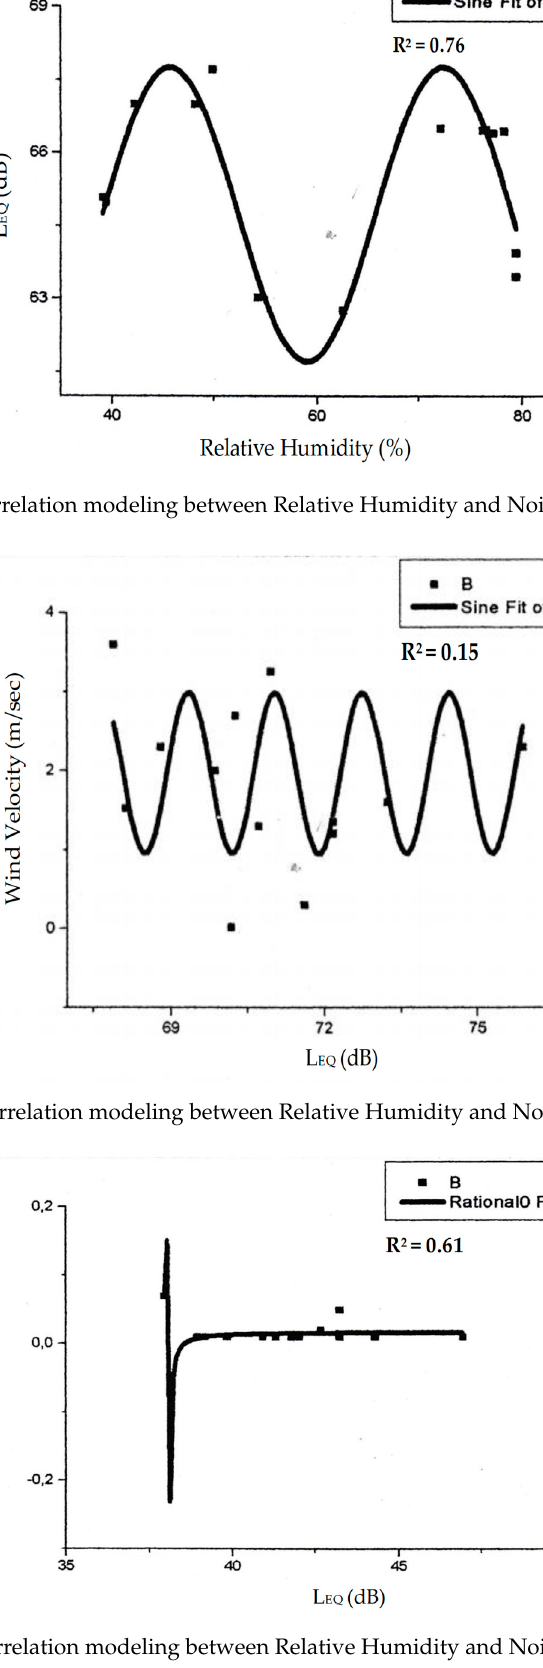
Figure 14. Correlation modeling between Relative Humidity and Noise Level at CW-T. The most interesting is that the wind velocity is actually less in influencing the noise level refer to the Table 16. The less influence occurs due to the configuration between buildings and other mass block surrounding the ground buildings. Moreover, when the correlation modeling between wind velocity and the noise had been changed into another modeling, the influence had been increased to be 0.61 (see Figure 14). The phenomenon occur due to the sinusoidal pattern of wind direction was reflected and broken by the building mass configuration[7]. 4.3. Theoretical validation of the Correlation Modeling